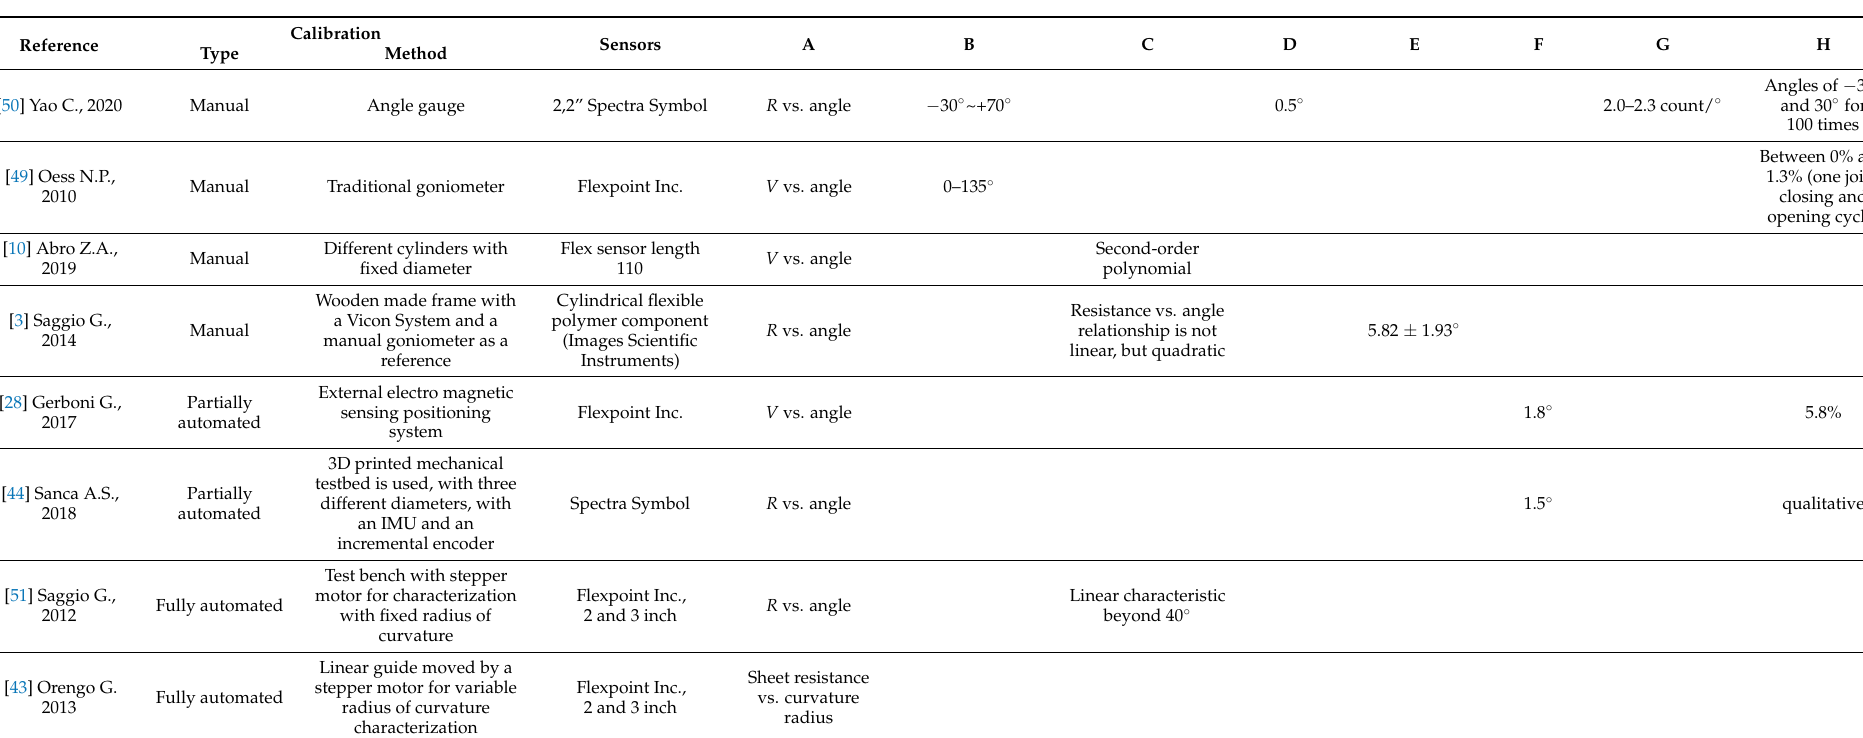
Table 7. Synthetic view of tools, methods and results related to the characterization of commercial bending sensors of related works in literature. A: Characteristic; B: maximum range; C: linearity; D: resolution; E: repeatability; F: accuracy; G: sensitivity; H: